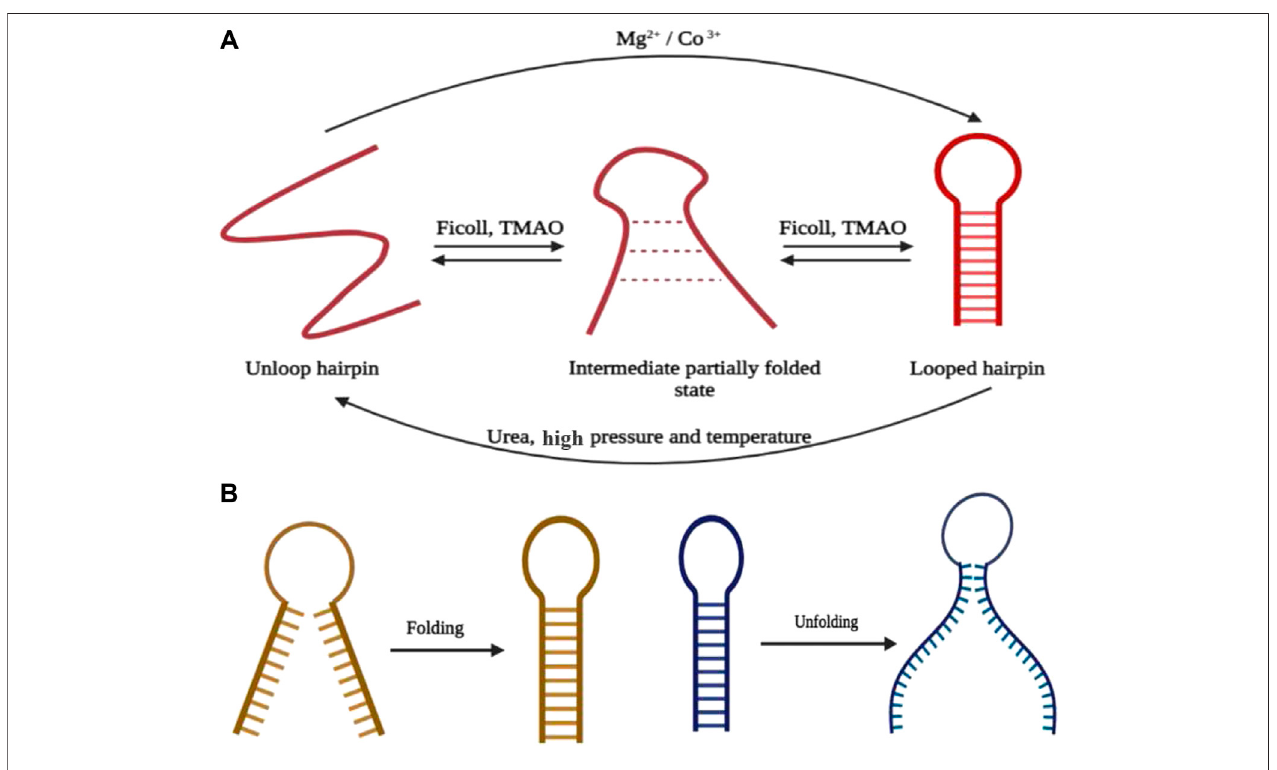
FIGURE 2 | (A) Summary of hairpin formation going through the intermediate state in the presence of different ions, cosolutes, and physical environmental conditions. (B) Mechanism of folding and unfolding of the hairpin through end-to-end collapse and unzipping from the end, respectively (created with BioRender.com).